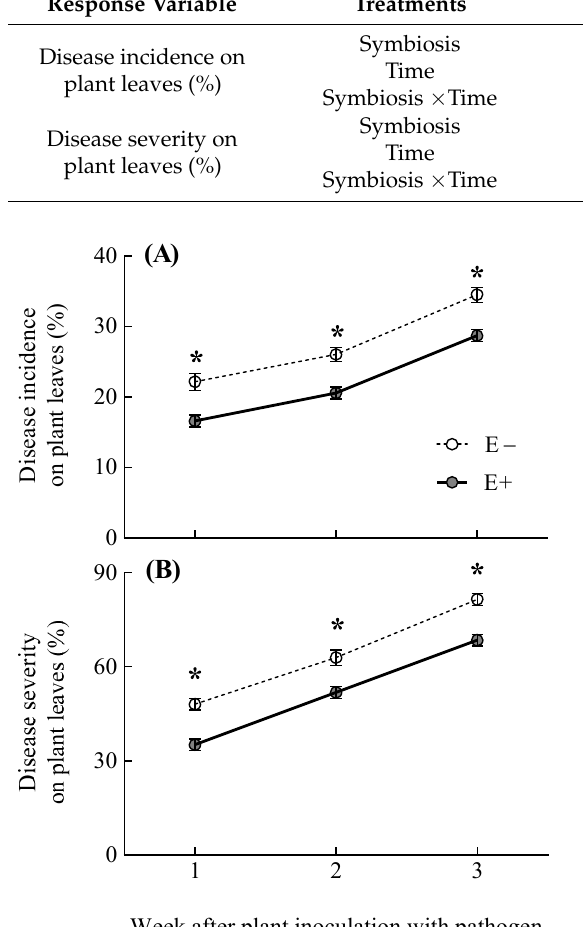
Table 2. Disease incidence and severity of the pathogen Blumeria graminis on leaves of Achnatherum inebrians plants with (E+) and without (E − ) the fungal endophyte Epichloë gansuensis along the experimental time. Statistically significant effects are highlighted in bold. Values of means, SEM, replicate numbers and post hoc statistical differences are showed at Figure 2A,B.